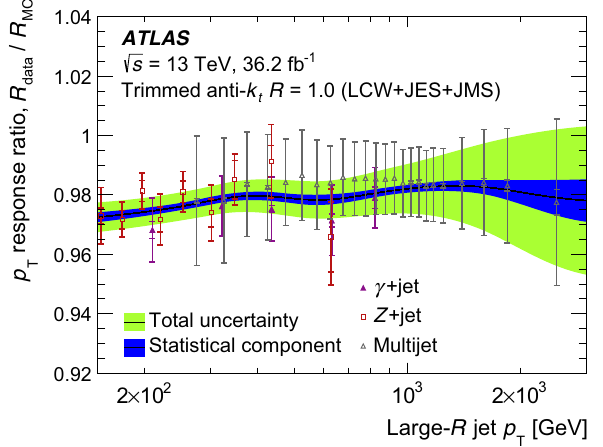
Fig. 27 The χ 2 / N dof of the combination of in situ measurements of the relative jet- p T response of large- R jets in data and simulations as a function of the jet transverse momentum p T . The χ 2 / N dof indicates the level of tension between the results of the γ +jet and multijet balance methods in each p T bin. For transverse momenta beyond 1 TeV, only one method is available, and the χ 2 / N dof goes to